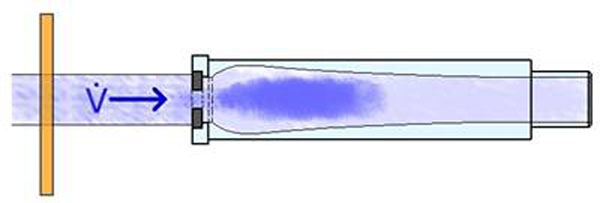
Slice positioning